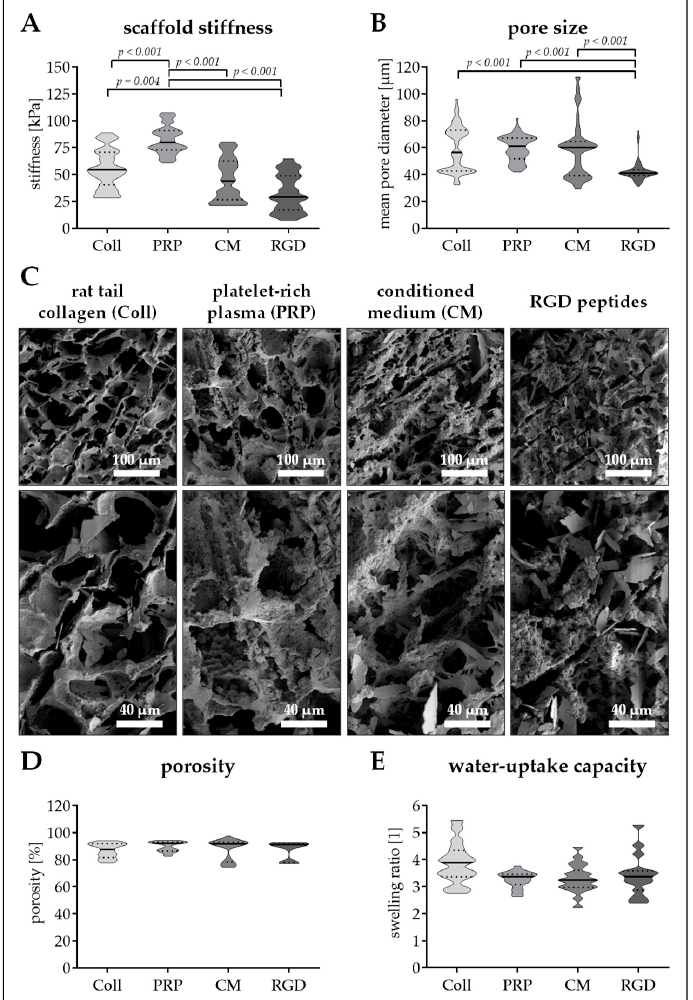
Figure 3. Pore size and stiffness of cryogels with different protein additives. Cryogels containing 16%